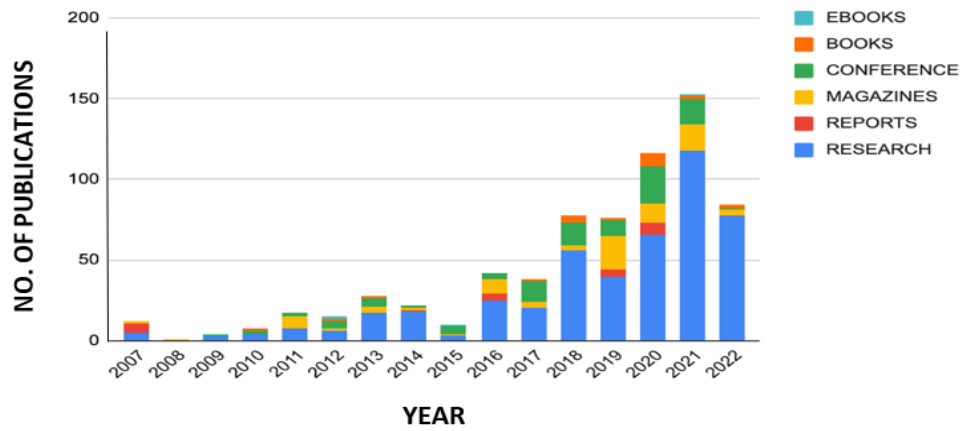
Figure 3. Number of publications based on floating PV systems by year.